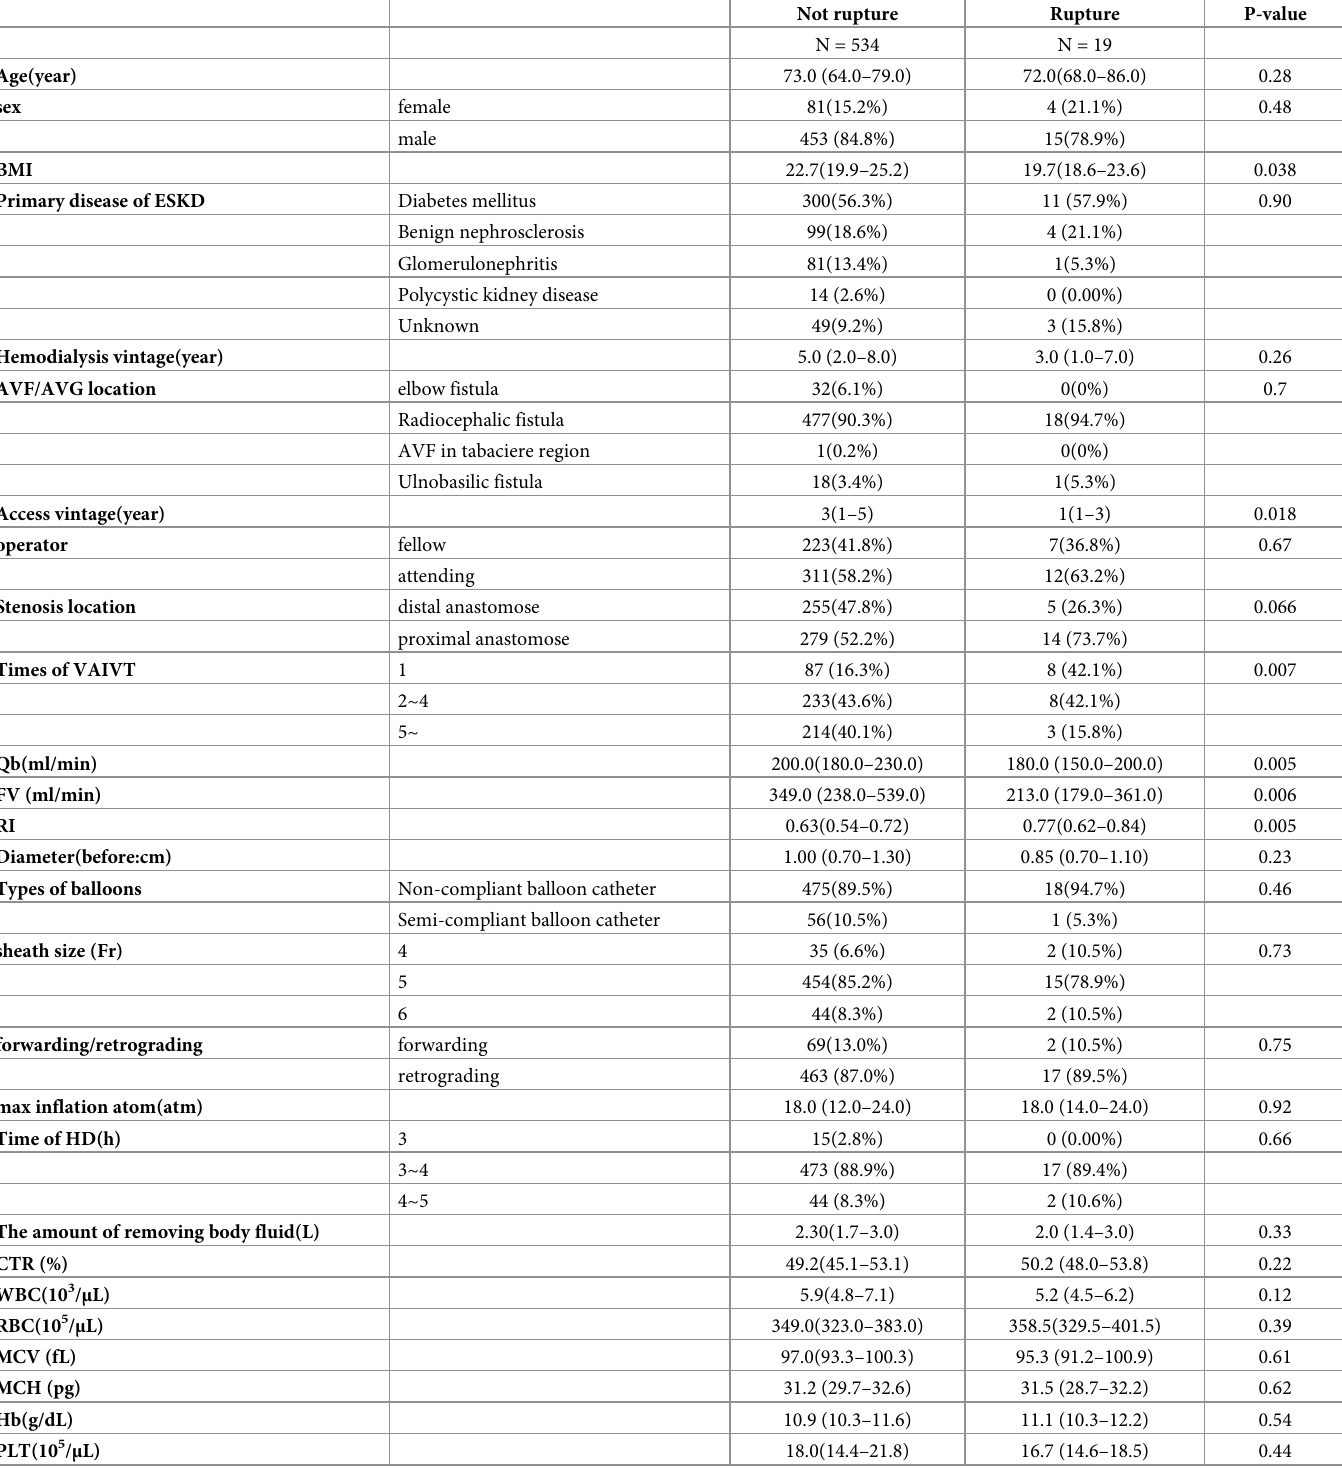
Table 2. Baseline clinical and biochemical characteristics of 553 patients with AVF receiving vascular access intervention therapy. (Wilcoxon-test or chi-square